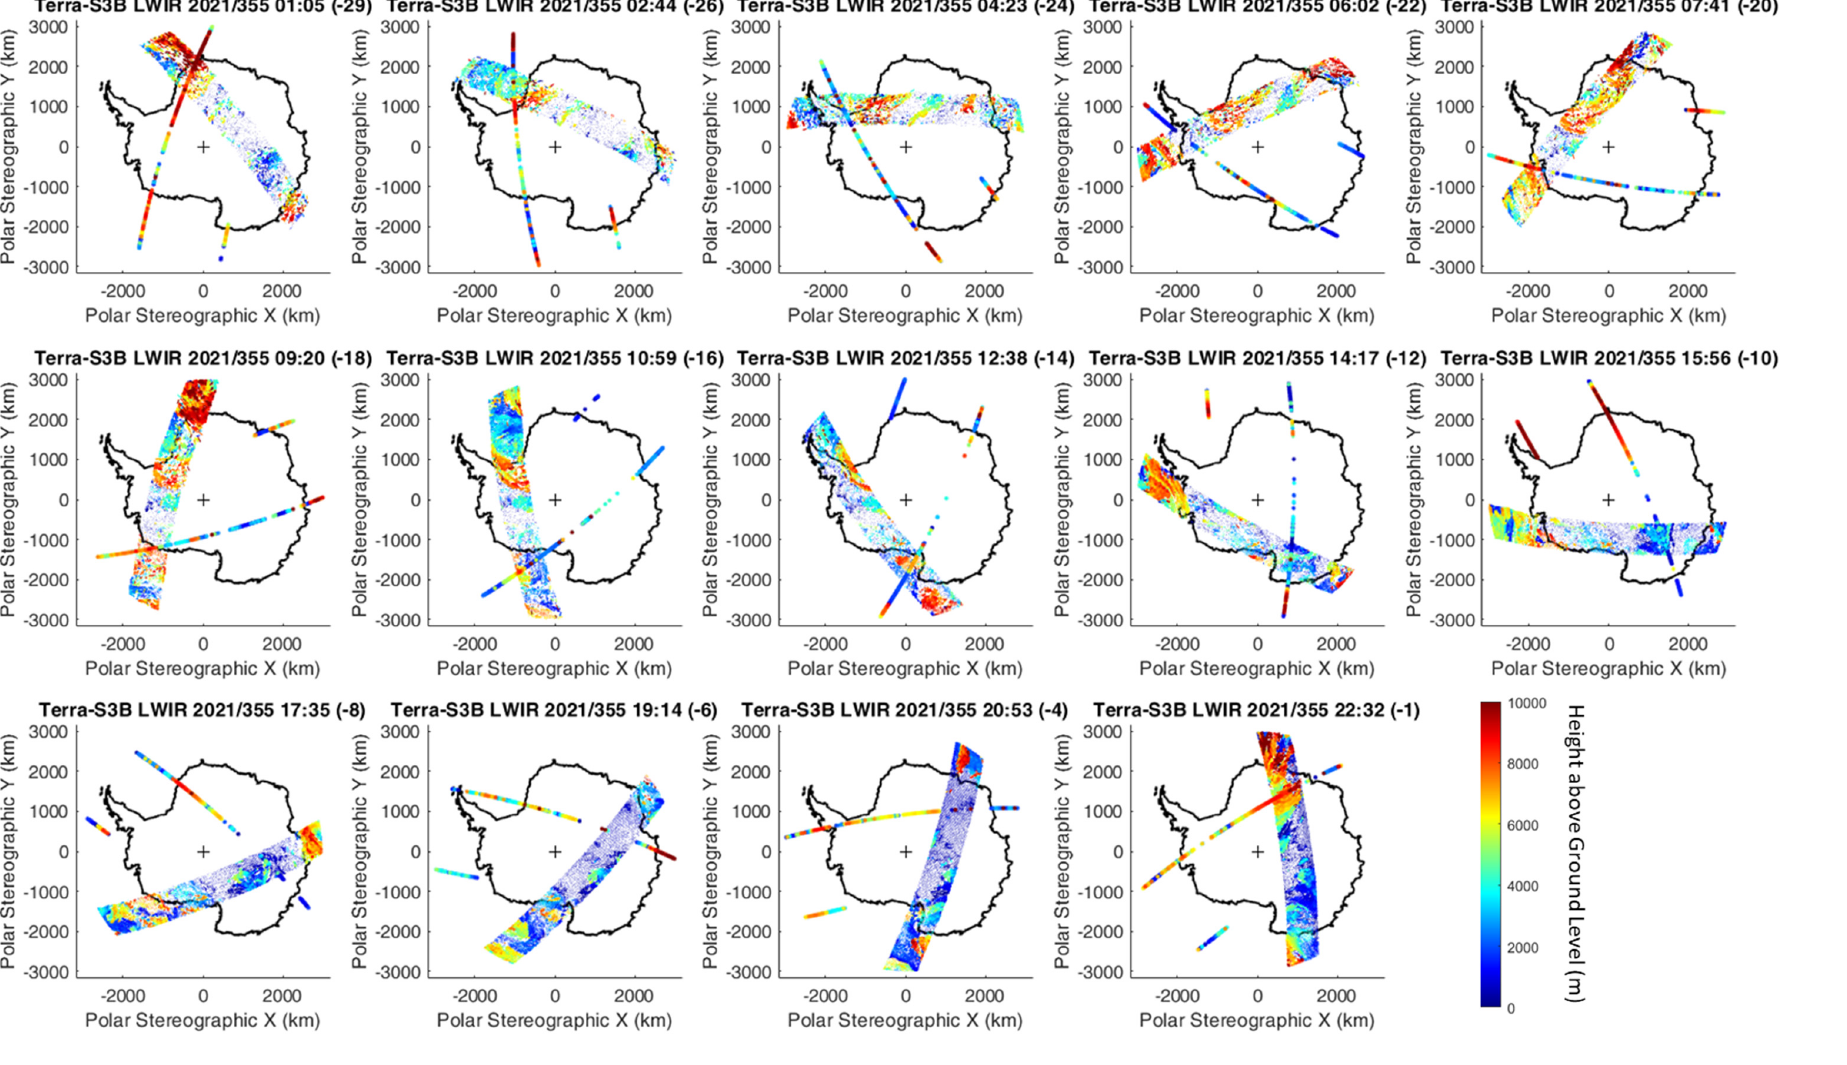
Figure A2. Terra and Sentinel-3B retrievals for South Polar summer (21 December 2021, LWIR).